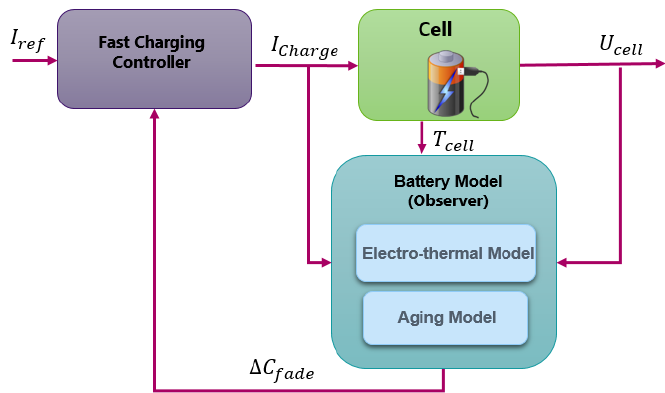
Figure 2. Description of the implementation of the fast charging functions in a battery management system (BMS).